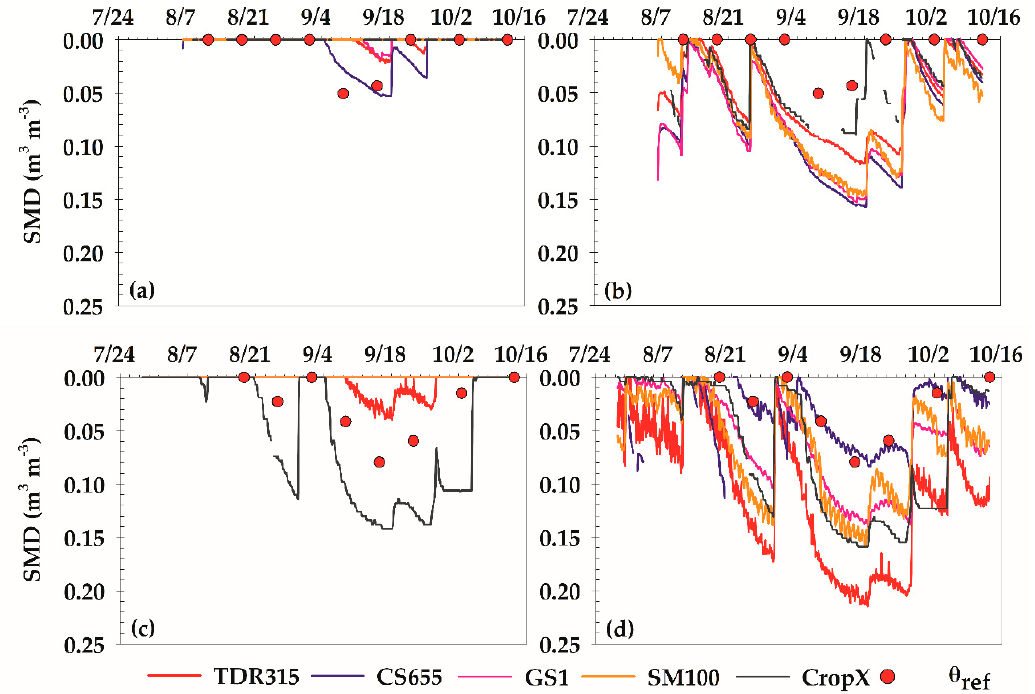
Figure 5. Time series of hourly soil moisture depletion (SMD) estimated based on sensor readings of θ v and FC estimates from laboratory ( a ) and ranking ( b ) methods at LSLC site and laboratory ( c ) and ranking ( d ) methods at HSHC site. Dots represent SMD estimated based on θ ref and FC estimates from laboratory method.